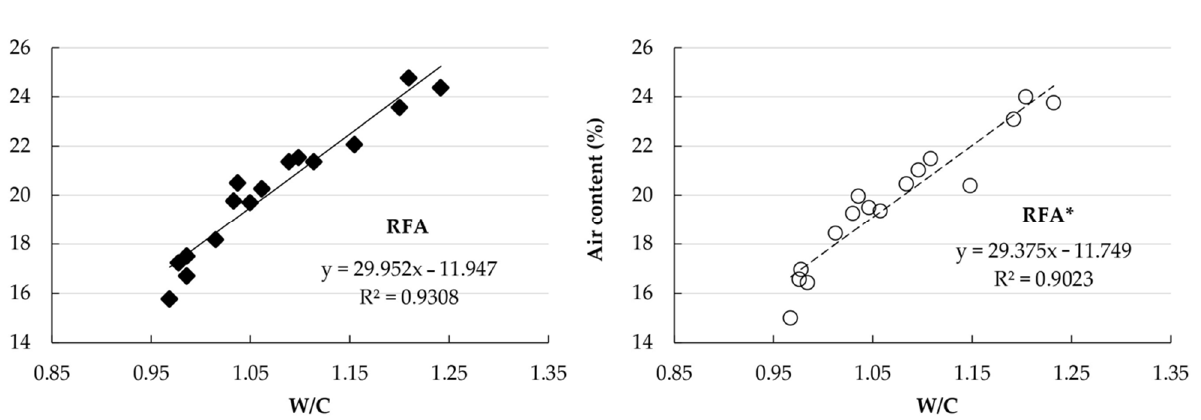
Figure 7. Correlation of air content and W/C ratio.